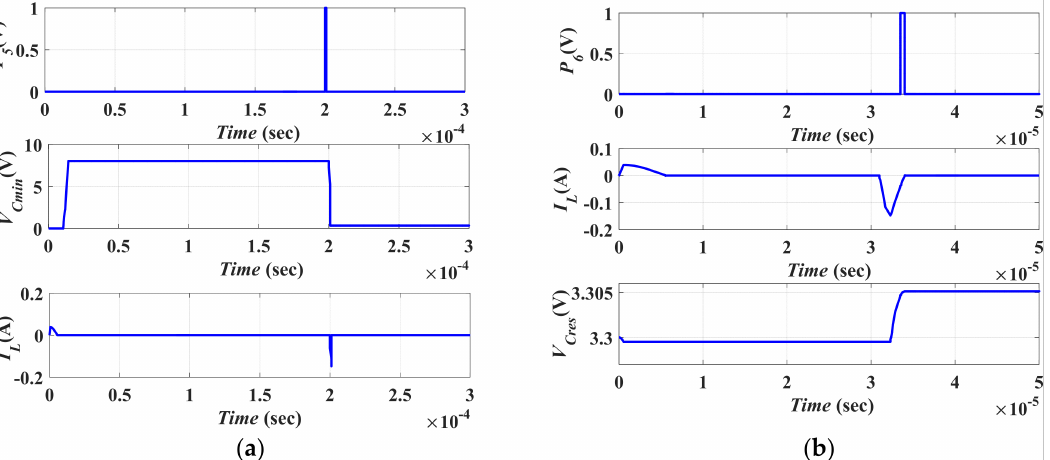
Figure 13. The third stage simulation results ( a ) The discharging of C min in L during PW 5 through S 4 and S 5 , and ( b ) Transferring the gained energy from L to C res during PW 6